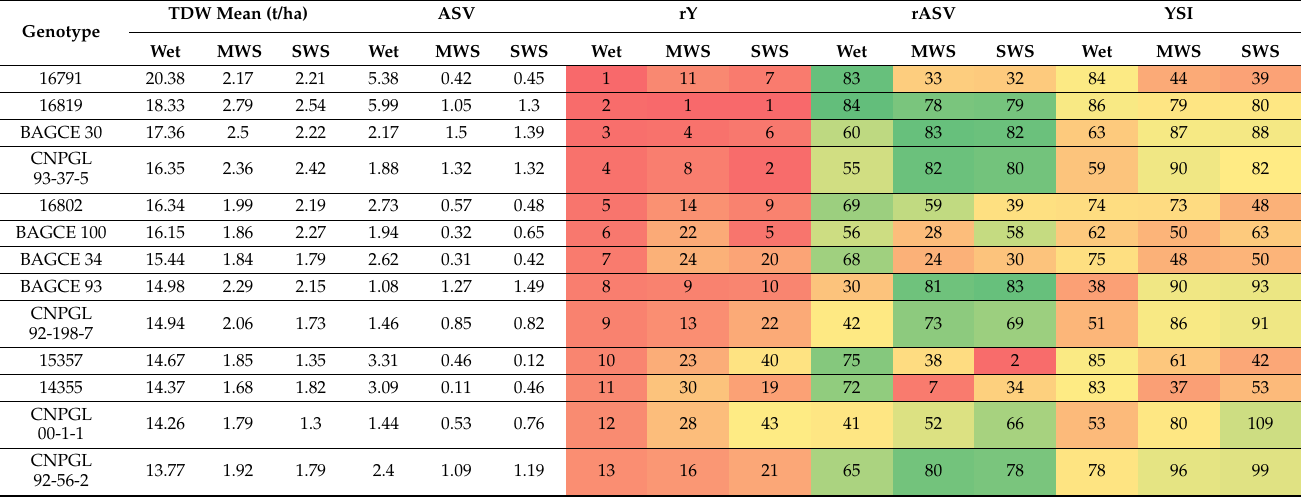
Table A5. AMMI stability variance, yield stability index and genotype rank under wet, MWS and SWS